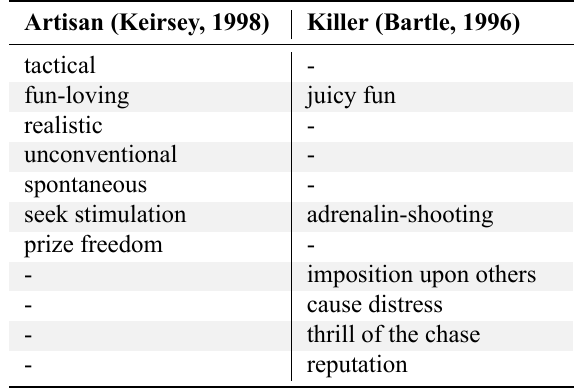
Table 4. Summary of analysis of correlation between